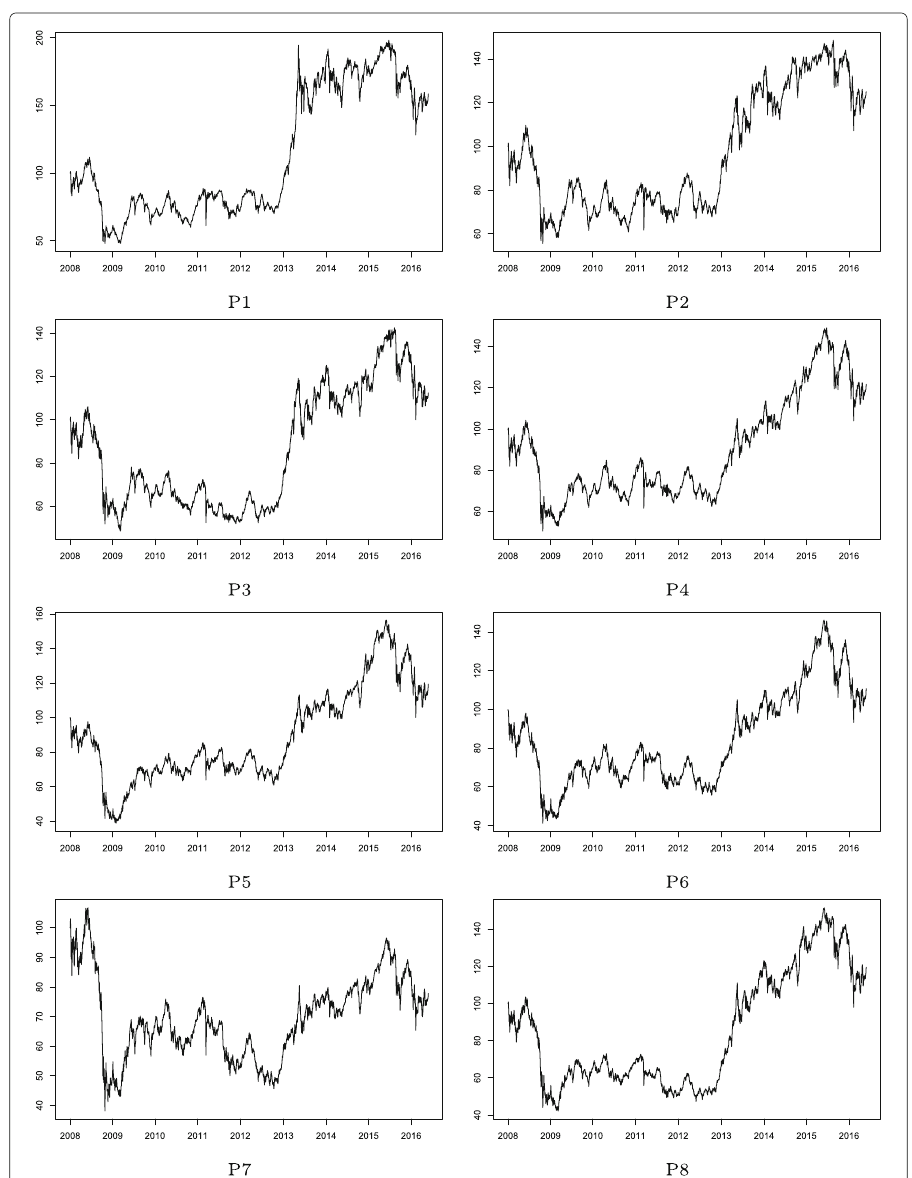
Fig. 2 Stock price indices: Cyclical group sub-portfolios. Note: The sub-groups of P1, P2, ..., and P8 correspond to the same group ids shown in Fig. 1. The stock price index of a sub-portfolio is first indexed as 100 at the beginning of the observation period (January 2008); then, the log returns of the mean value of the portfolio is calculated. The price index figures of sub-groups appear to be similar to each other because of the market-wide common price co-movements in the stock market. Some local temporal differences between sub-groups still exist, reflecting local group-specific common factors